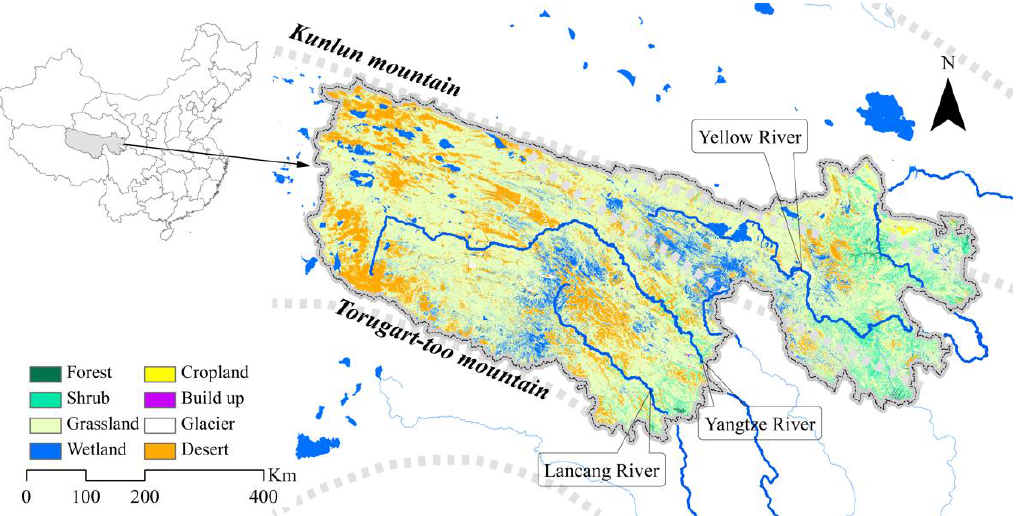
Figure 1. Grassland distribution of the Three Rivers headwater region (The gray bold dashed lines represent the mountains with a name beside it; the blue lines are the rivers; spatial reference: Albers conical equal area; datum: D WGS 1984).